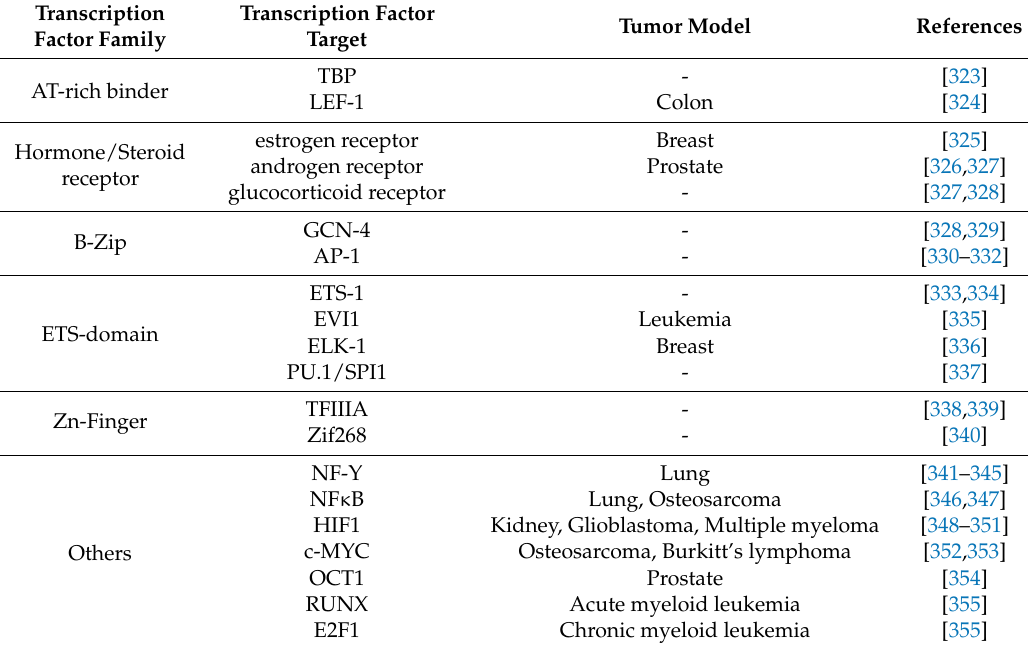
Table 2. Examples of polyamides targeting oncogenic transcription